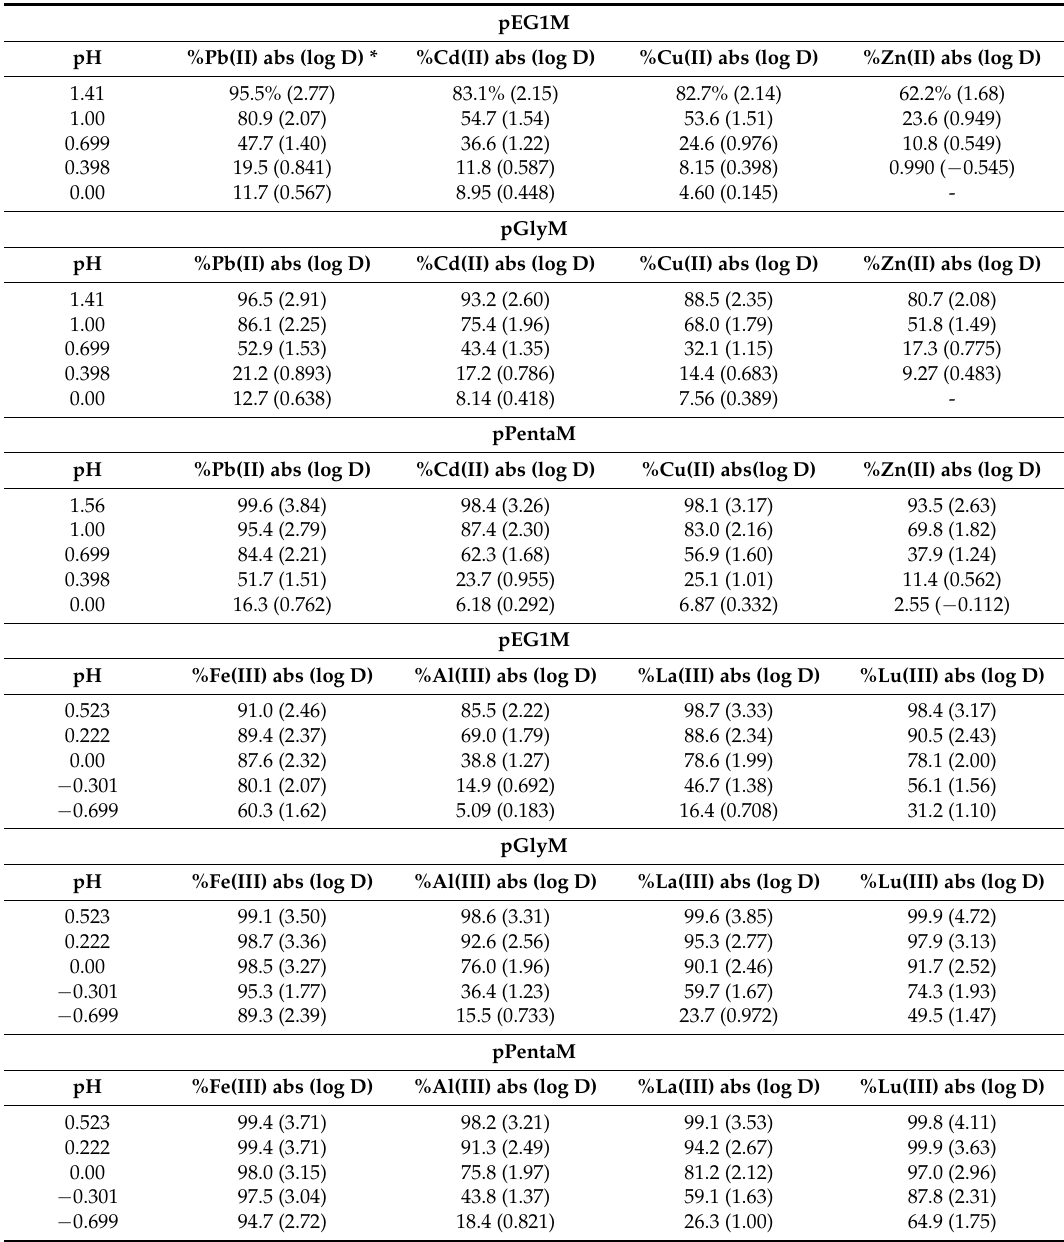
Table 2. Metal ion affinities of the monoprotic